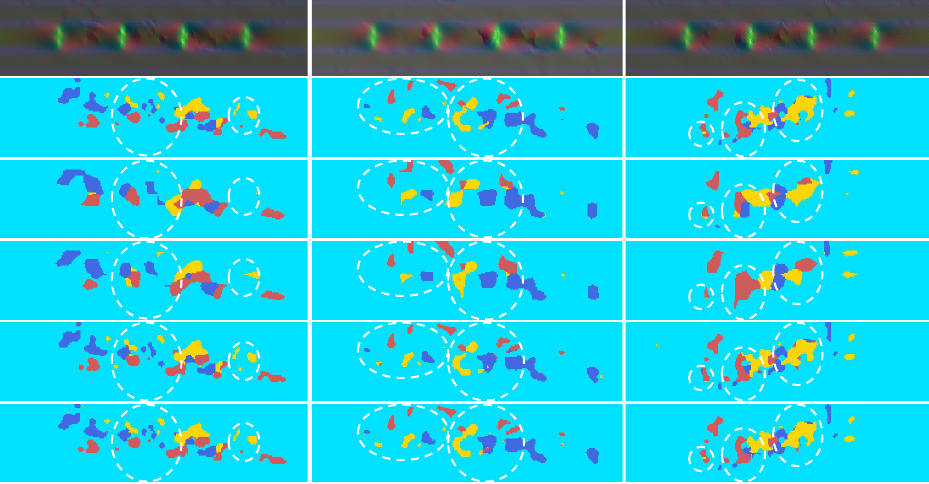
Figure 11. Test result of DeepLabV3, PSPnet, UNet, and SDFormer on the sleeper beam